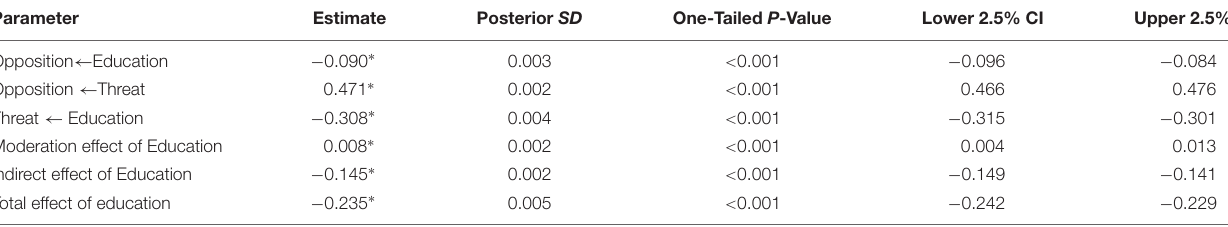
TABLE 5 | Baseline model examining the association between education and opposition to migration. Parameter Estimate Posterior SD One-Tailed P -Value Lower 2.5% CI Upper 2.5% CI